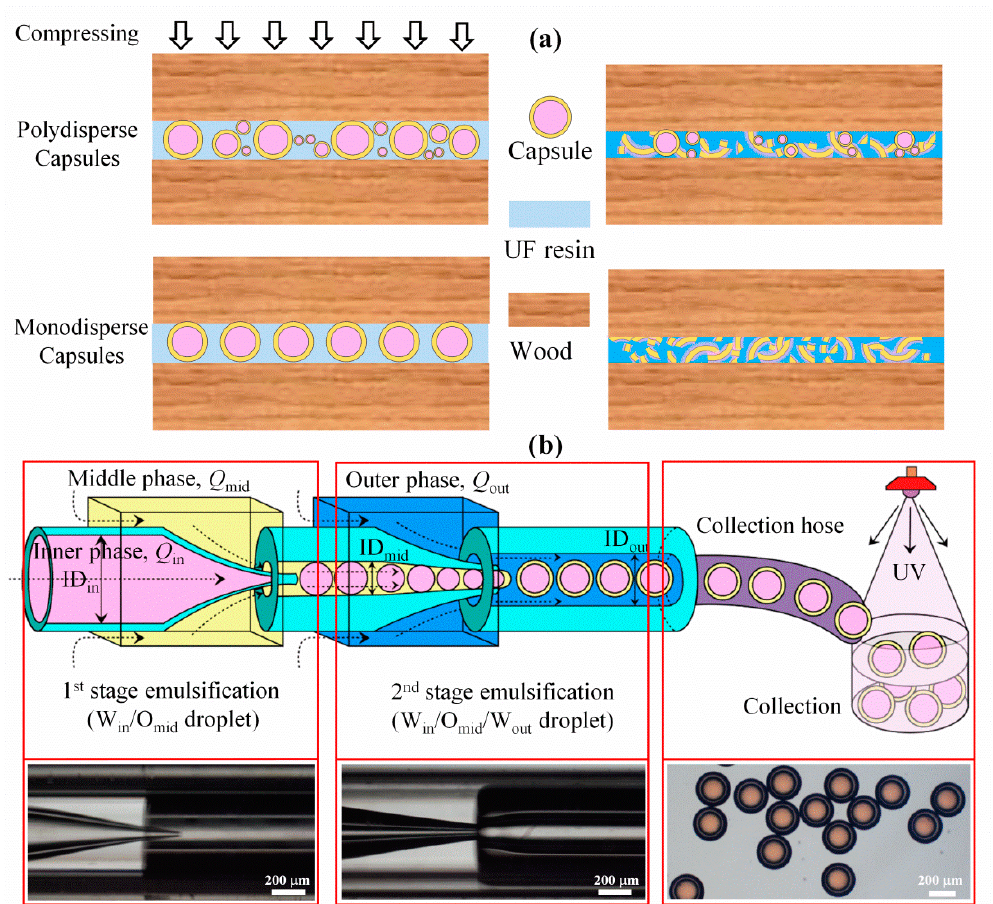
Figure 1. ( a ) Schematic working mechanism of the capsules-based pressure-sensitive adhesive (PSA) with polydisperse (top) and monodisperse (bottom) microcapsules. ( b ) Schematic (top row) and optical images (bottom row) showing the step-by-step process of constructing monodisperse microcapsules using a capillary microfluidic device for preparing the double-emulsion droplets, and UV irradiation for polymerizing the middle phase to form the shells to obtain microcapsules.